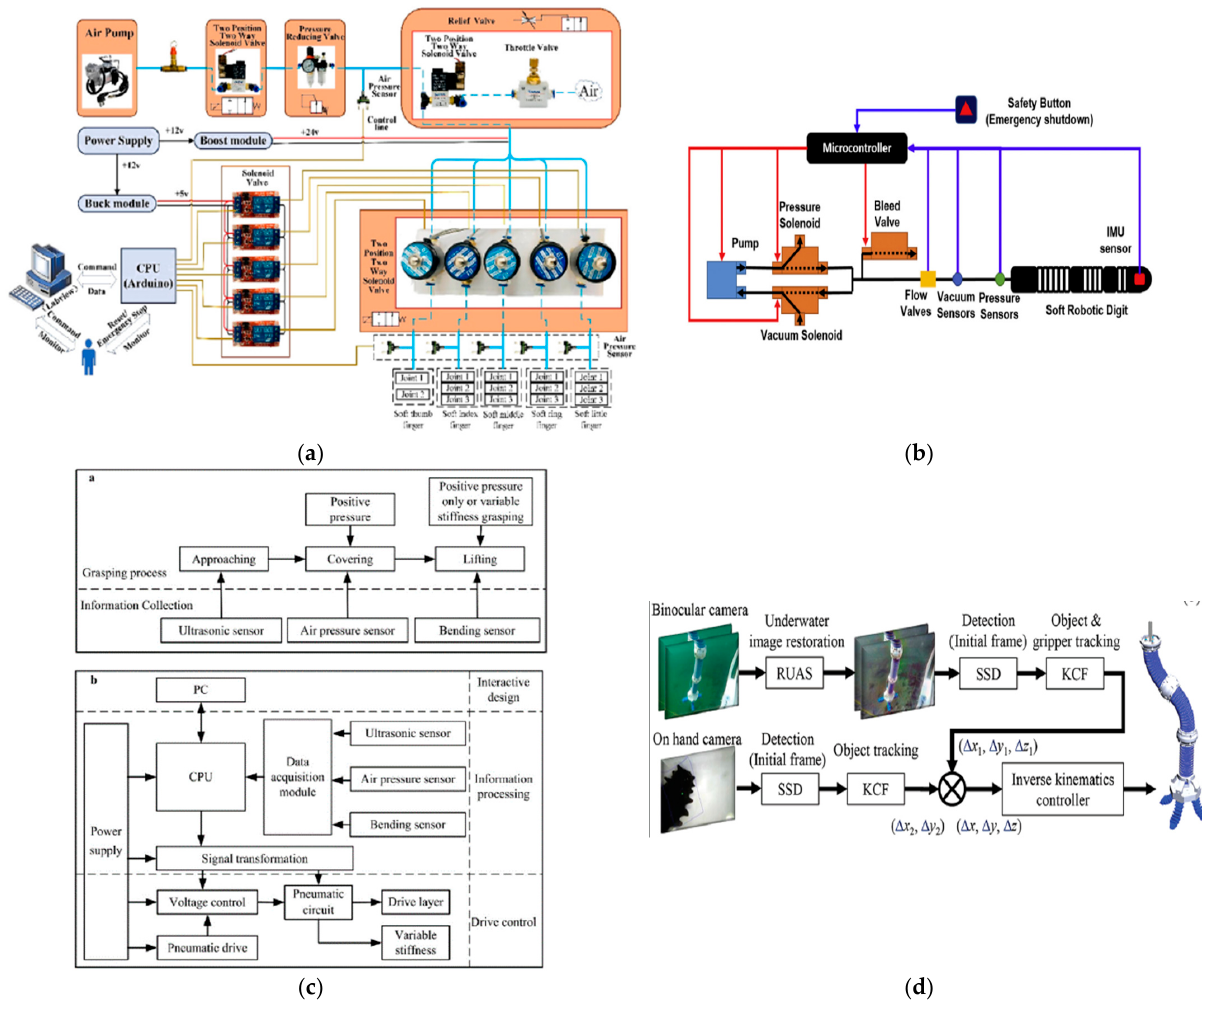
Figure 4. ( a ) Control using vacuum actuation; reproduced with permission [28]; published by ELSEVIER, 2019.; ( b ) diagram of a fluid actuator hand control scheme; reproduced with permission from [53]; published by ELSEVIER, 2020; ( c ) prehensor control based on a fluid actuator with scales inspired by pangolin skin structure; reproduced with permission from [54]; published by ELSEVIER, 2020; ( d ) control scheme of a manipulator with joints based on rotating fluidic actuators [55]. Nguyen et al. developed a pneumatically operated manipulator with a built-in gripper for handling tasks with various objects. The manipulator is positioned on the person’s body, representing an upper third limb. It is controlled by the user via a joystick and is equipped with EMG sensors to capture muscle intention [59]. Cheng et al. proposed a manipulator based on SMA actuators that has nine degrees of freedom and closed-loop control that employs gyroscope and accelerometer modules [60] or manipulators driven by SMA coils and Hall sensors [61]. Li et al. proposed an SMA-driven manipulator position control method based on fuzzy delay algorithms to increase manipulator accuracy due to the nonlinear hysteretic behavior of SMAs [62]. Jizhuang et al. approached the control of the frog robot through an open-loop control system that connected an HC-12 module to the robot microcontroller, which allowed the robot to be controlled from a PC. The drive system is specific to pneumatic actuators and the robot has high autonomy while not being tied to an external power source [41].